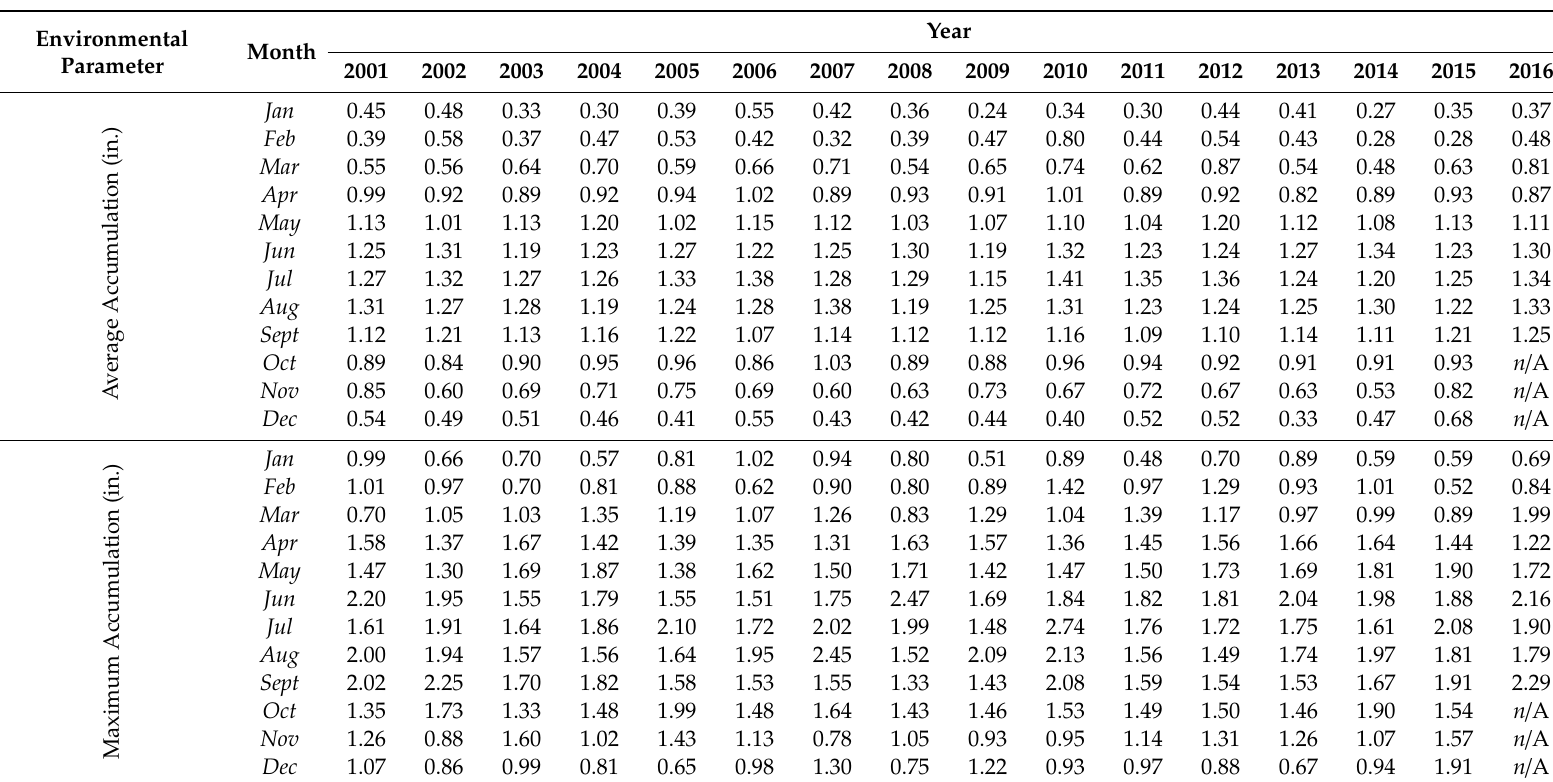
Table A1. Environmental parameters statewide for years 2001–2016, displaying monthly means for each respective parameter and year combination.